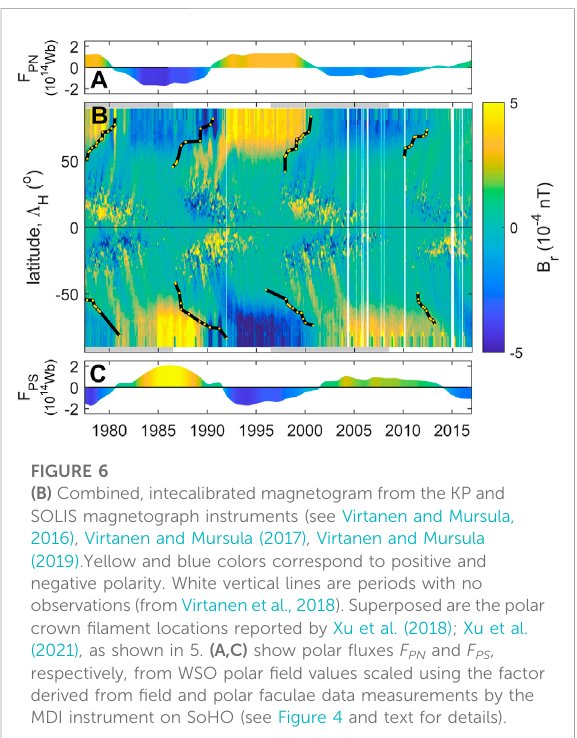
FIGURE 6 (B) Combined, intecalibrated magnetogram from the KP and SOLIS magnetograph instruments (see Virtanen and Mursula, 2016), Virtanen and Mursula (2017), Virtanen and Mursula (2019).Yellow and blue colors correspond to positive and negative polarity. White vertical lines are periods with no observations (from Virtanen et al., 2018). Superposed are the polar crown fi lament locations reported by Xu et al. (2018); Xu et al. (2021), as shown in 5. (A,C) show polar fl uxes F PN and F PS , respectively, from WSO polar fi eld values scaled using the factor derived from fi eld and polar faculae data measurements by the MDI instrument on SoHO (see Figure 4 and text for